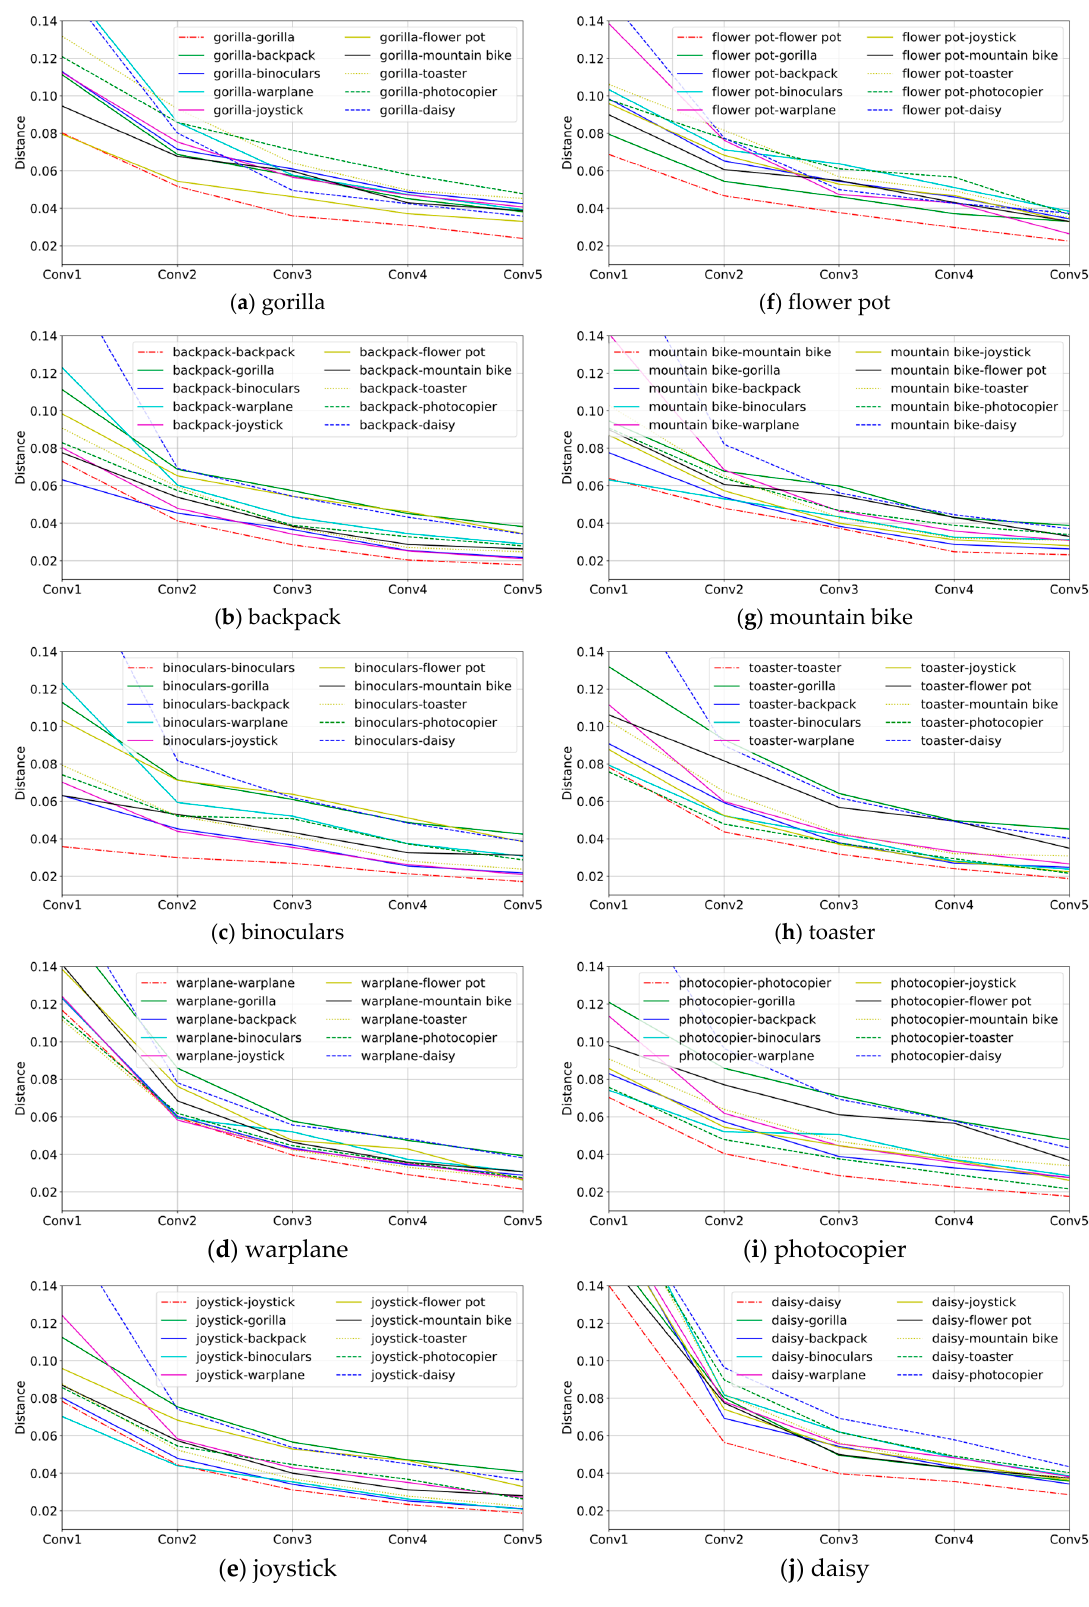
Figure 4. Distance between feature vectors for each class. The red dashed-dotted line is the distance 216 between images of same class. The distances between images of the same class are less than those 217 between images of different classes. 218